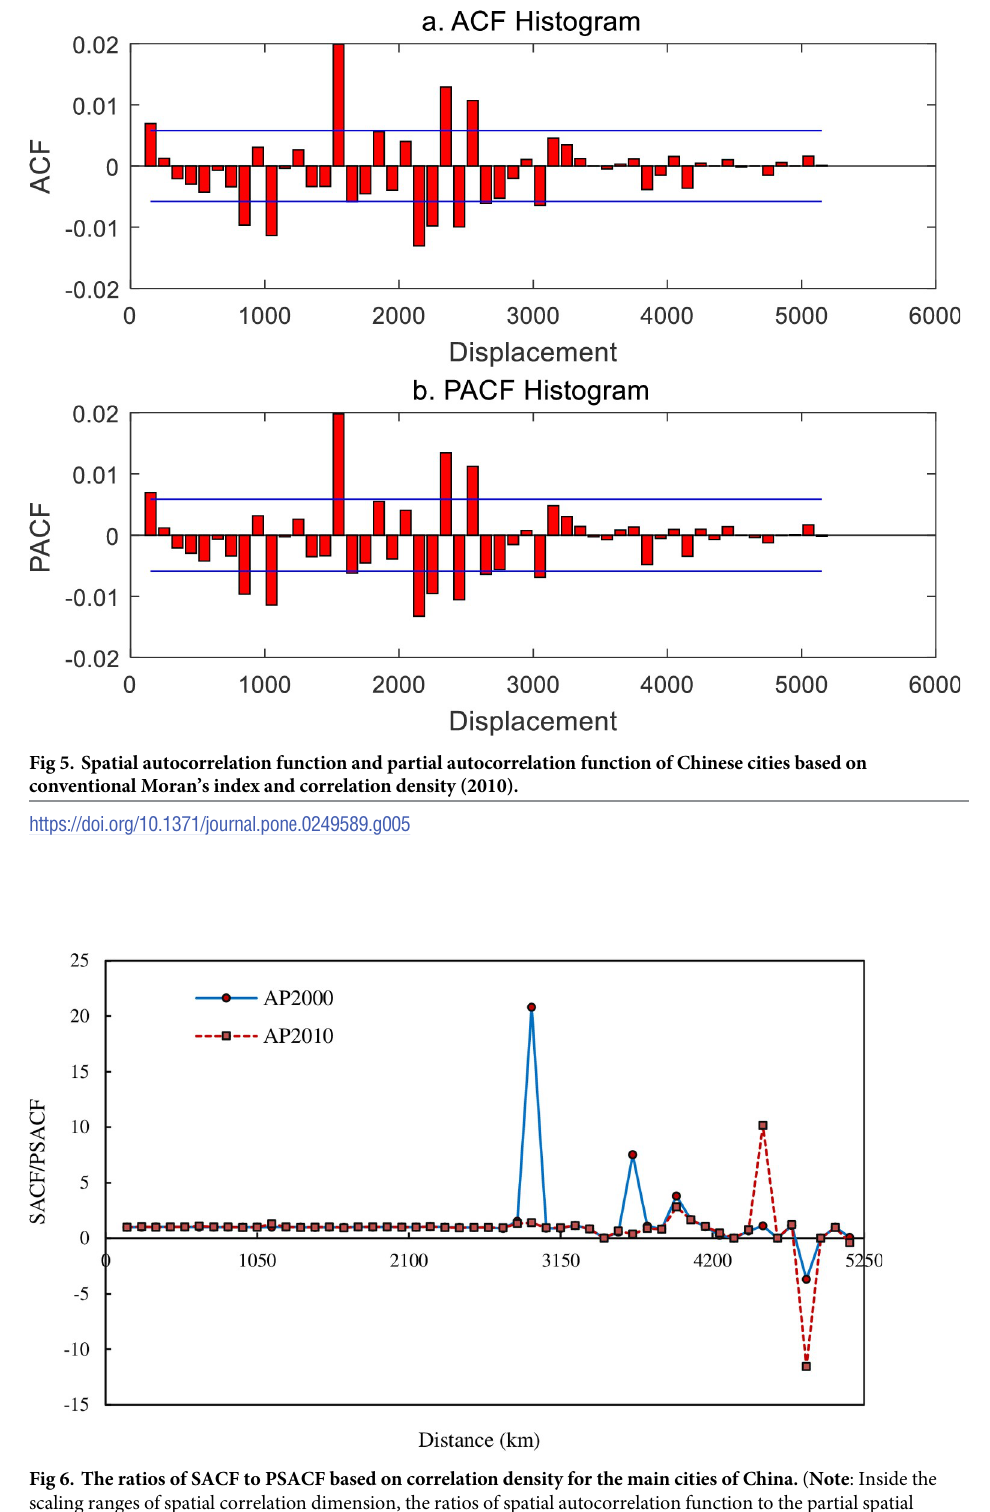
PLOS ONE | https://doi.org/10.1371/journal.pone.0249589 April 14,